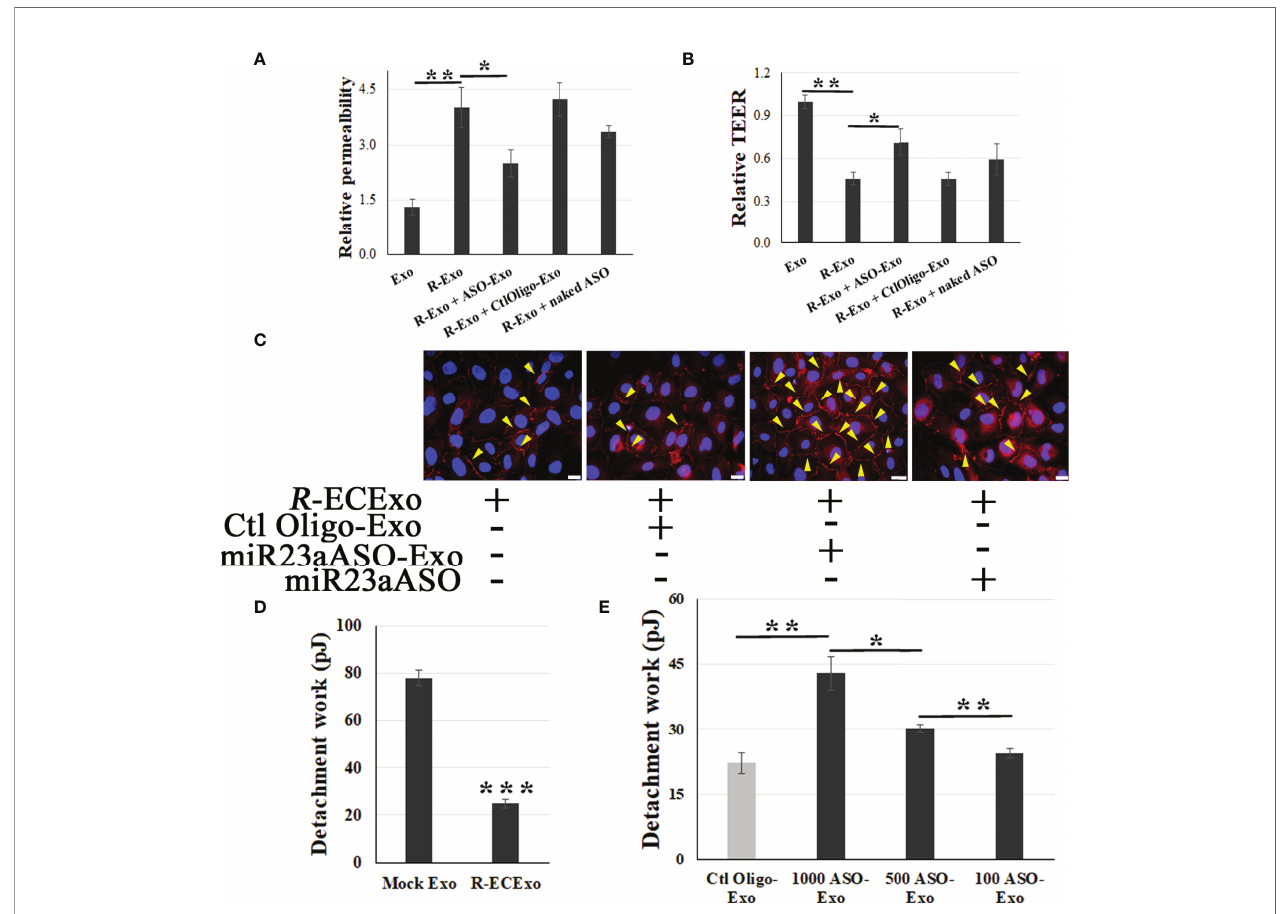
FIGURE 5 | miR23a ASO-enriched ECExos ameliorate R -ECExo-provoked recipient BMEC dysfunction in association with stabilization of ZO-1. A and B, compared to naked miR23a ASO (naked ASO) and Ctl Oligo-enriched ECExos (Ctl Oligo-Exos), miR23a ASO-enriched ECExos (ASO-Exo) attenuate R -ECExo- ( R -Exo-) induced enhanced permeability to FITC-dextran (A) and reduced TEER (B) , respectively, in recipient BMECs. (C) , Representative immuno fl uorescence staining of ZO-1 in recipient BMECs that, after exposure to R -ECExos ( R -Exo) for 6 hr, were treated with naked miR23a ASO (miR23aASO), Ctl Oligo-Exos, or miR23aASO-Exo for 66 hrs. (D) , Exposure to R -ECExos in normal media weaken the LBF, indicated by the detachment work (in pJ) between recipient BMECs measured using fl uidic AFM at 72 hr post exposure. *** p <0.001. E, Compared to Ctl Oligo-Exo, treatment with miR23a ASO-enriched ECExos (ASO-Exo) ameliorate weakened LBFs in R - ECExo-treated BMECs, in a dose-dependent manner. * p <0.05; ** p